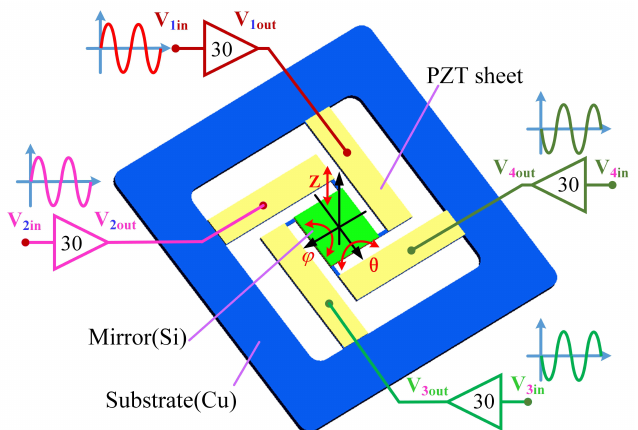
Figure 1. Working principle of the 3-DOF flexible piezoelectric nano-positioning stage.